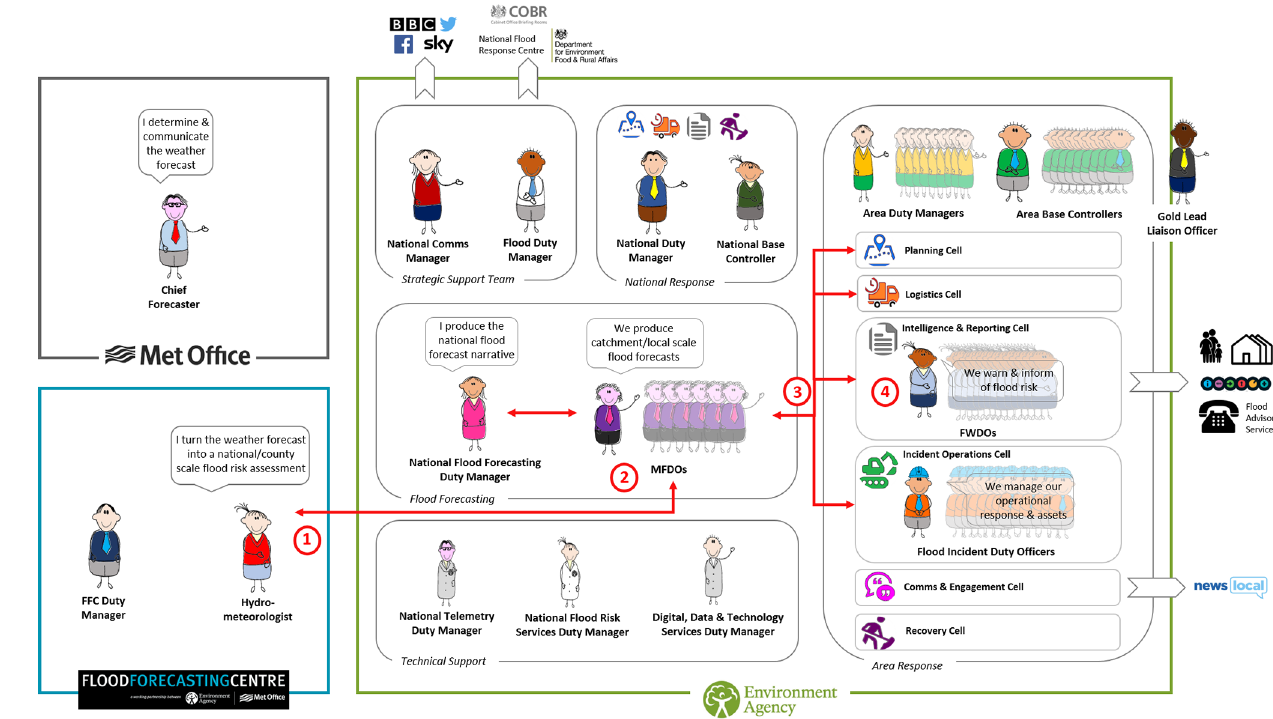
Figure 2. Schematic of the EA’s institutional landscape and the flood incident management information flow between MFDOs, FWDOs and first-degree contact points (red arrows) (source: EA). The numbers highlight the structure of Sect.